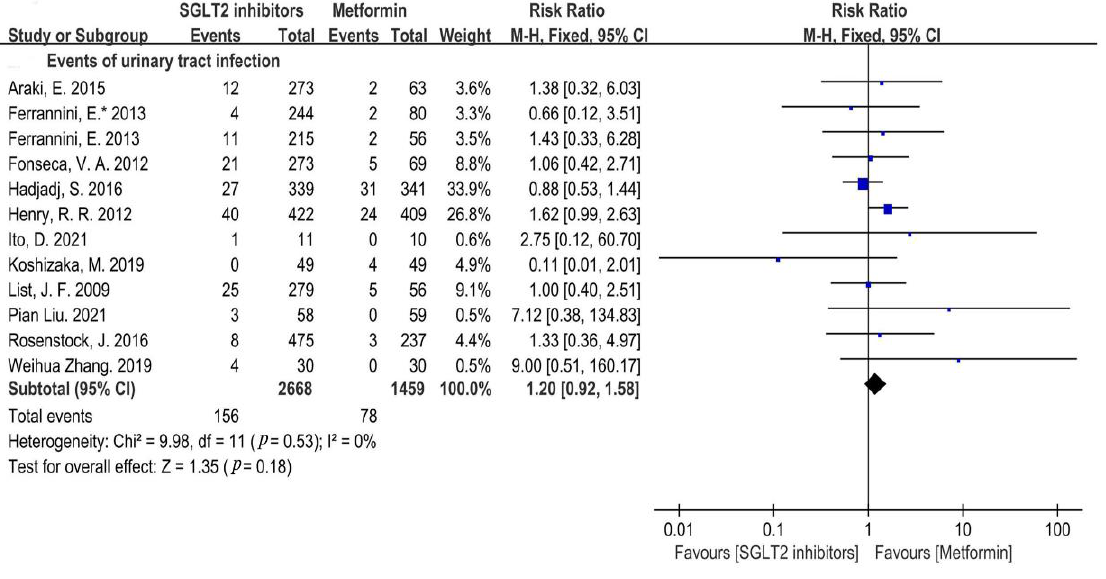
Figure 5. Risk of urinary tract infections in patients with SGLT2i compared with that of metformin [20 – 29,31,32].